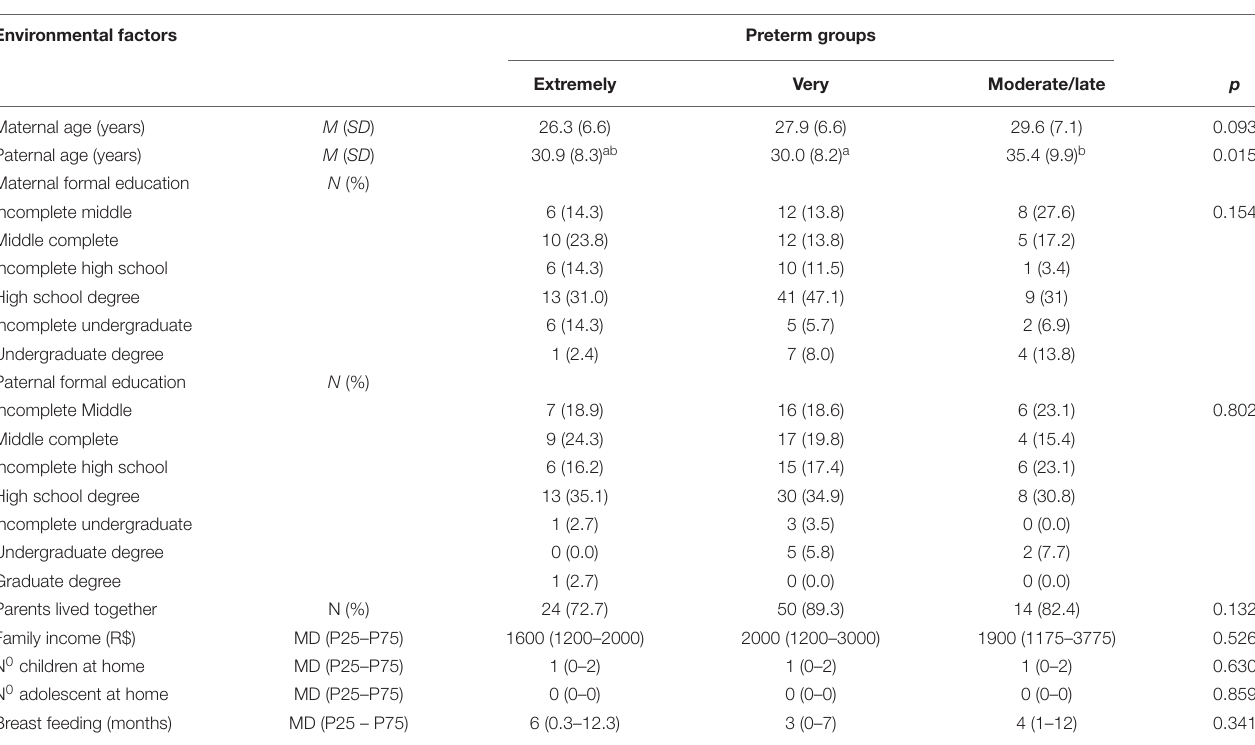
TABLE 3 | Environment factors and group